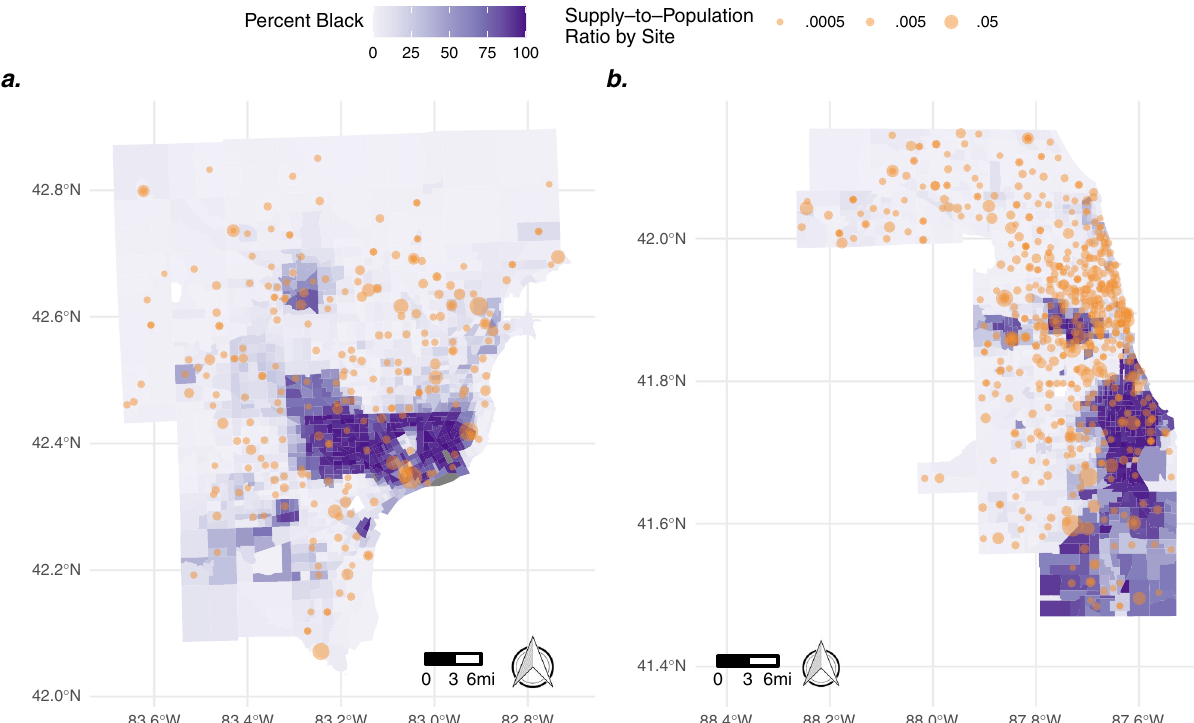
Fig. 4 Disparities in COVID-19 vaccine access in Detroit and Chicago, USA. Map of census tracts around Detroit, Michigan ( a ) and Chicago, Illinois ( b ) by the percentage of residents who are Black ( purple ). Overlayed in orange are COVID-19 vaccine distribution locations sized by their supply-to-population ratio. Vaccine distribution sites (from Vaccines.gov) in both cities are sparser in census tracts with a higher percentage of Black